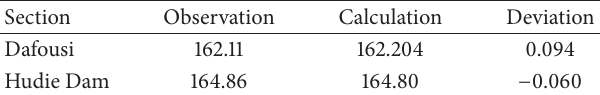
Table 2: The water level of calculate and observation. Observation